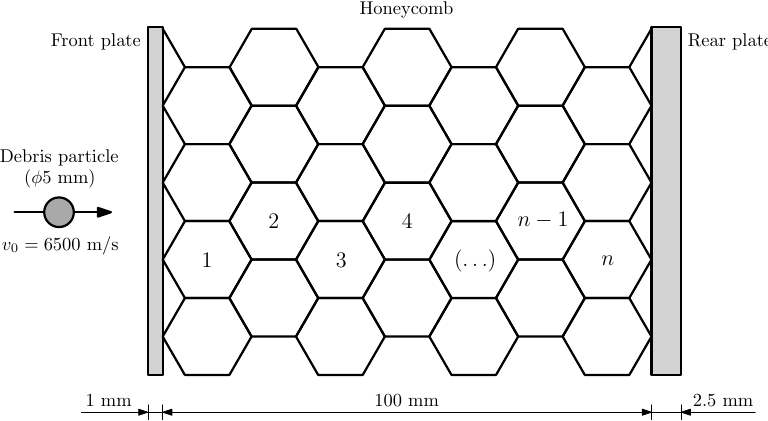
Figure 4. Honeycomb Whipple shield configuration with cell numbering, sequentially from the front towards the back